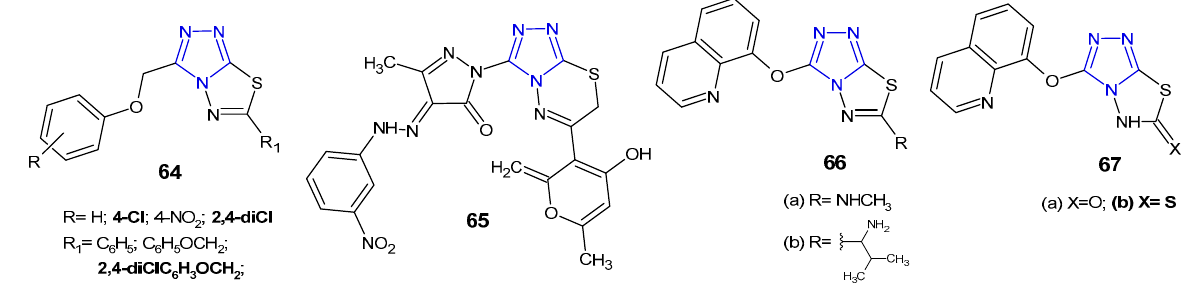
Figure 20. Antibacterial derivatives of 1,2,4-triazolo[3,4- b ][1,3,4]thiadiazoles and 1,2,4-triazolo[3,4- b ][1,3,4]thiadiazines—